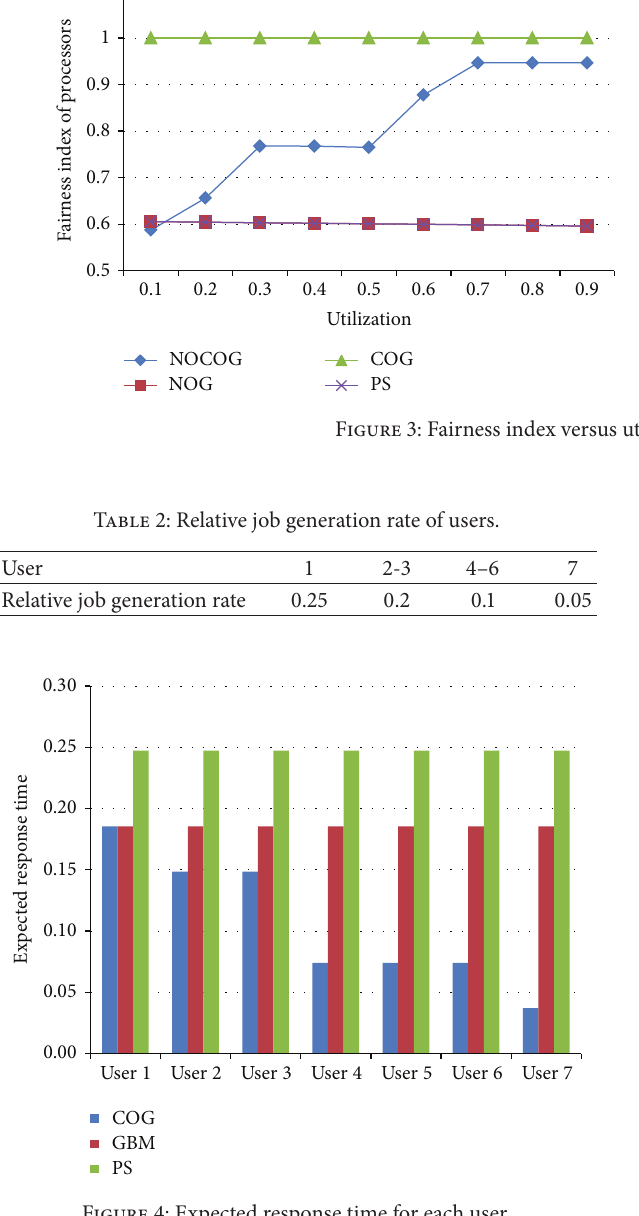
Figure 4: Expected response time for each